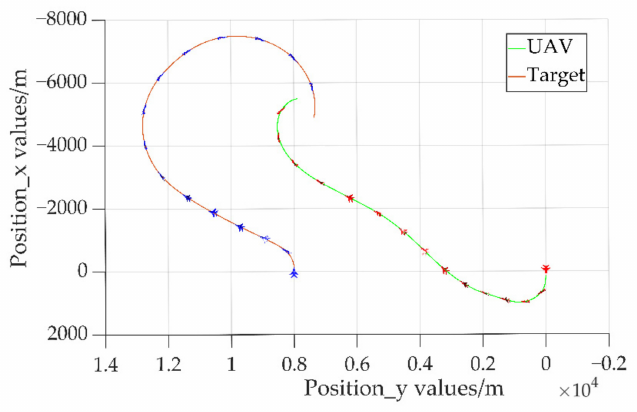
Figure 8. Air combat plane trajectory of two aircraft in case